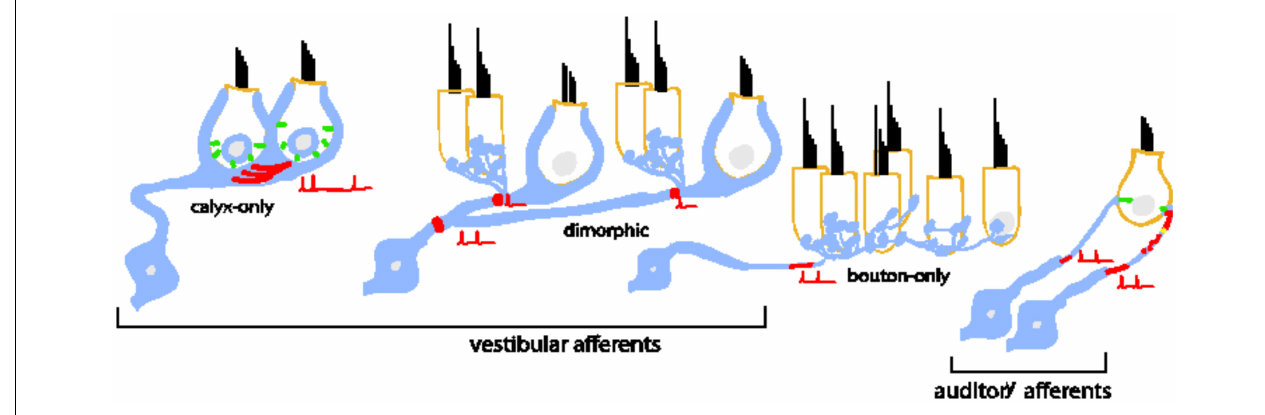
FIGURE 1 | Bipolar neurons of the inner ear are diverse in their morphology, dendritic arborization, and patterns of connectivity with inner hair cells. Type I spiral ganglion afferents in the auditory nerve have a single dendritic terminal that receives input from a single ribbon synapse at an inner hair cell. An individual inner hair cell has many synaptic ribbons that provide input to many Type I spiral ganglion neurons with a wide range of sound intensity thresholds. Vestibular afferents have diverse dendritic morphologies. Some neurons form post-synaptic calyx terminals that envelop the entire basal pole of Type I vestibular hair cells. Other neurons branch extensively to make many bouton terminals on Type II hair cells. A large group of neurons is dimorphic because the neurons form both calyceal and bouton terminals on Type I and Type II hair cells. The prevalence of dendritic morphology changes based on epithelial zone. Pure calyx afferents tend to be found in the central zones of vestibular epithelia where irregular-timing spiking is prevalent in vivo . Bouton afferents are found in the peripheral zones where regular-timing spiking is prevalent. Dimorphic afferents are found throughout. In both bipolar neuron groups, spike initiation occurs on the dendrite near the